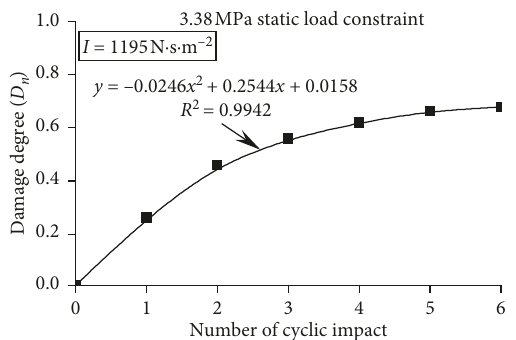
Figure 8: The relationship between damage degree and constant